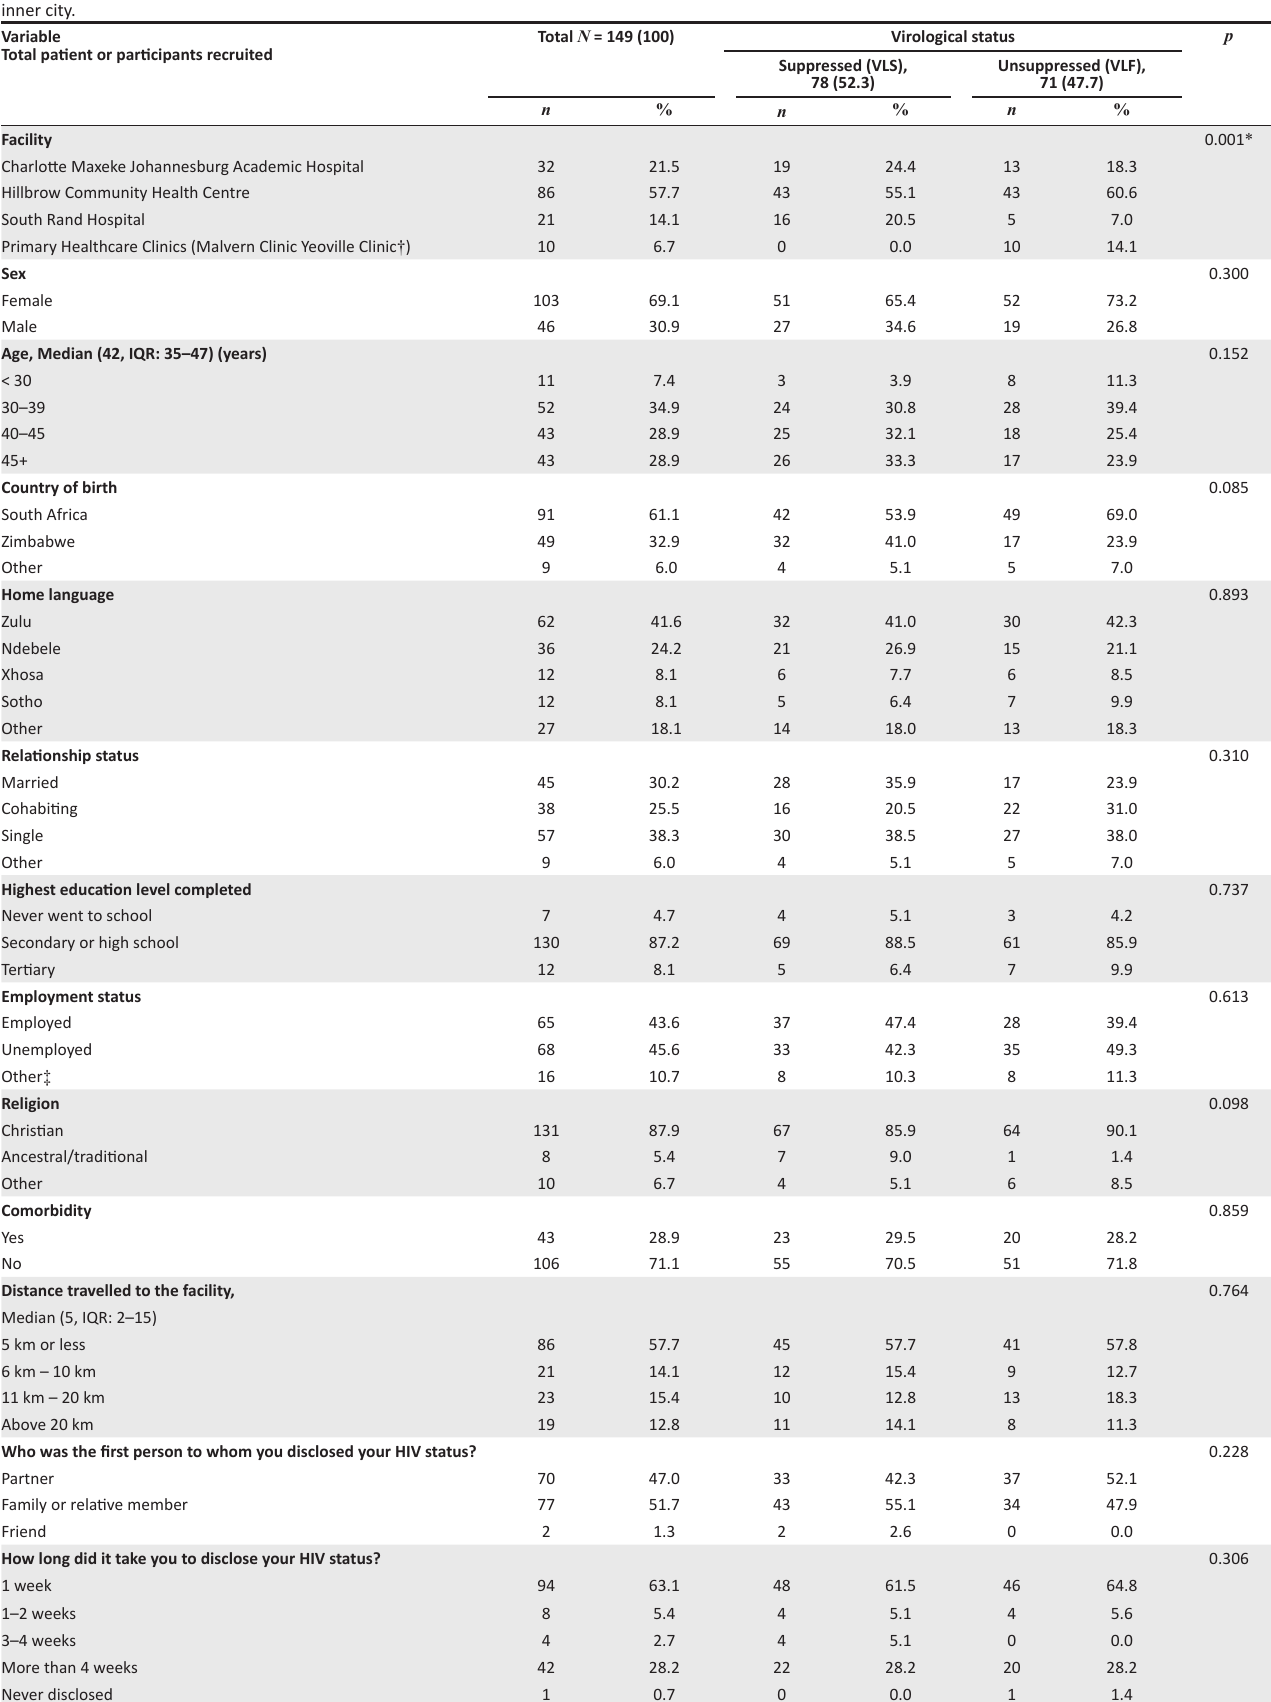
TABLE 1: Socio-demographic and treatment-taking characteristics disaggregated by virological status of second-line participants in five health facilities in the Johannesburg inner city. Variable Total patient or participants